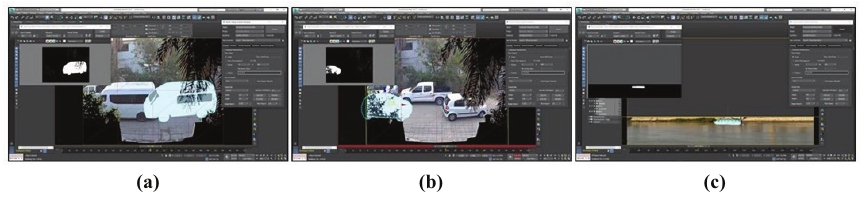
Fig. 6. Rendering on (a) van (b) car and (c)